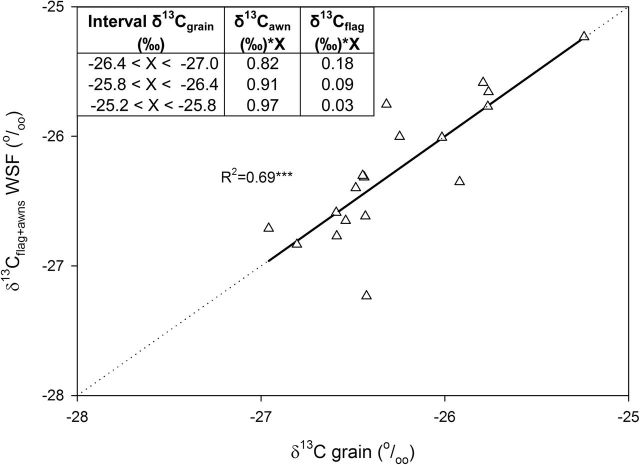
Linear regression of the relationship between stable carbon isotope composition in mature grains (δ13Cgrains) and the combination of the δ13C from the flag leaf blade and the awns (δ13Cflag+δ13Cawns) in the WSF. The individual values of δ13Cawn and δ13Cflag used in the linear regression were the average of the δ13C in the WSF before and after irrigation. The six genotypes with three replications per genotype were considered. For each plot, the relative weight assigned to the δ13C of each of the two organs depended on the water status of the plot assessed by its δ13Cgrains (see inset). Level of significance: ***P<0.001.